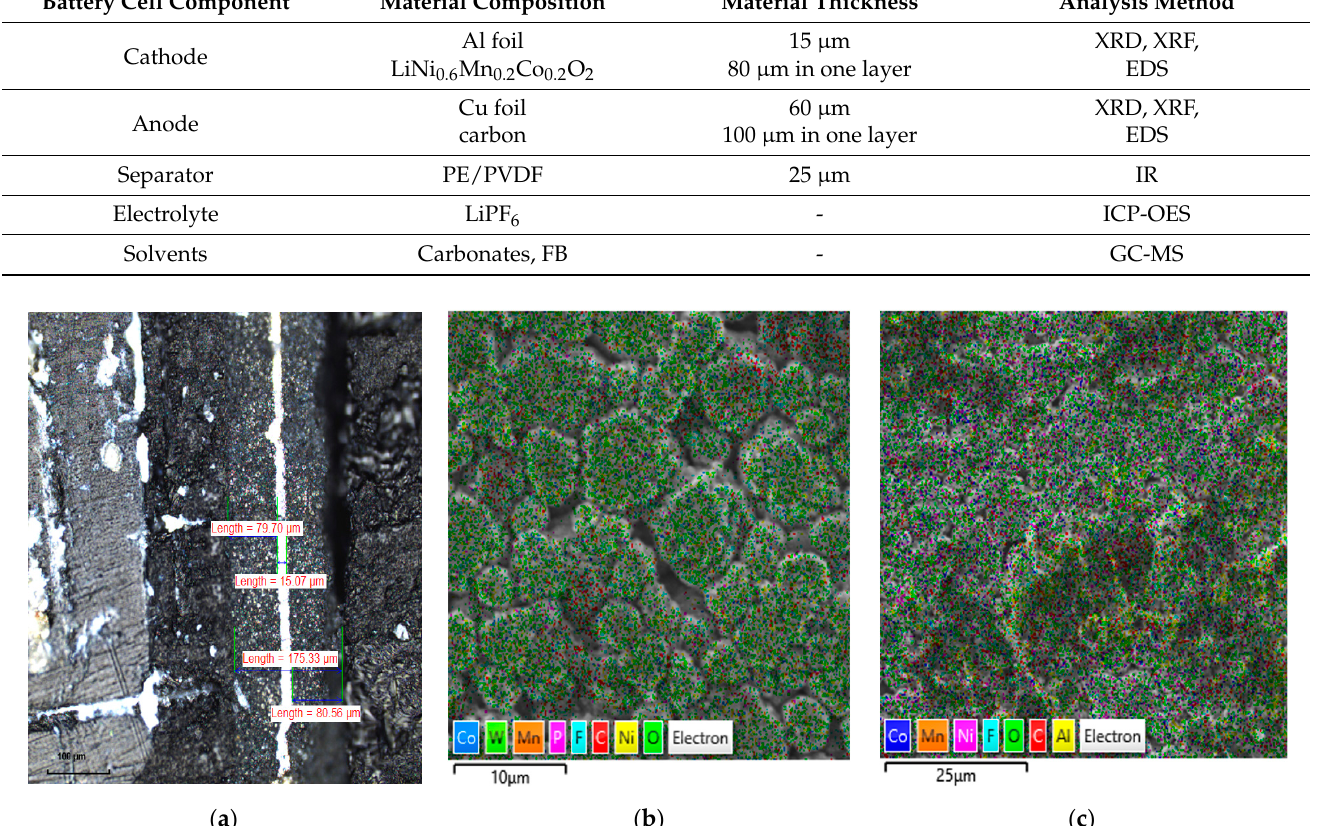
Figure 4. The cathode of the battery cell: (a) Cross-section of a spinel double layer on Al foil with an illustration of materials layer thickness; (b) EDS element map of visually pure side of spinel layer; (c) EDS element map of spinel layer with separator residues.